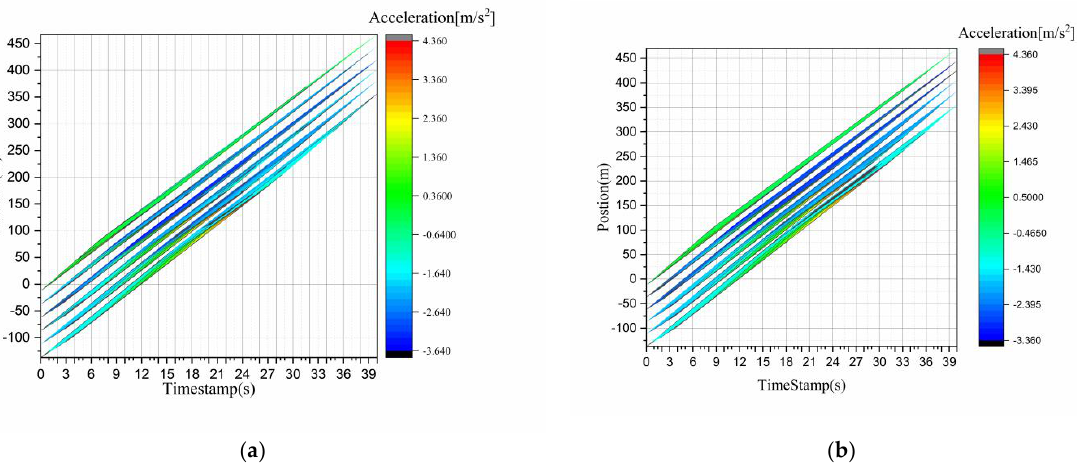
Figure 19. Acceleration heatmaps of CAVF fleet and CACCNF fleet under scenario 4: ( a ) CAVF acceleration heatmap; ( b ) CACCNF acceleration heatmap. acceleration heatmap; ( b ) CACCNF acceleration heatmap.